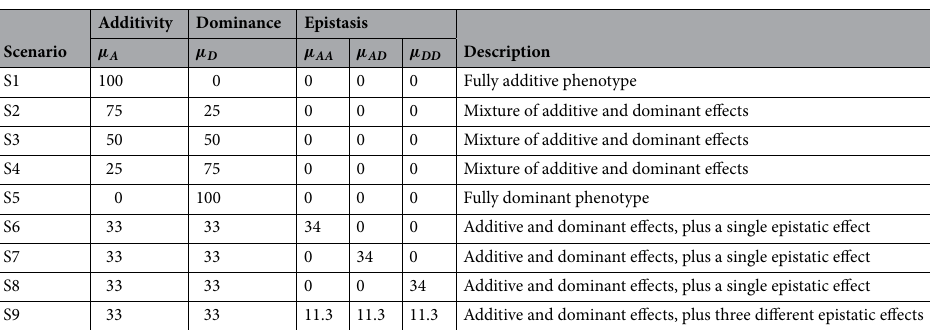
Table 1. The simulated phenotype scenarios. In each scenario a fixed number of SNPs ( QTN = 1000 ) were randomly selected and assigned additive effects sampled from a normal distribution with mean µ A , a fixed coefficient of variation ( cv = 0.1 ) and thus a determined standard deviation ( σ = cv · µ = 0.1 µ ). The operation is repeated for dominant and epistatic effects using the distribution means reported in the corresponding columns. Three types of epistatic effects are considered, when the interacting loci have both additive (AA), both dominant (DD), or additive and dominant (AD)